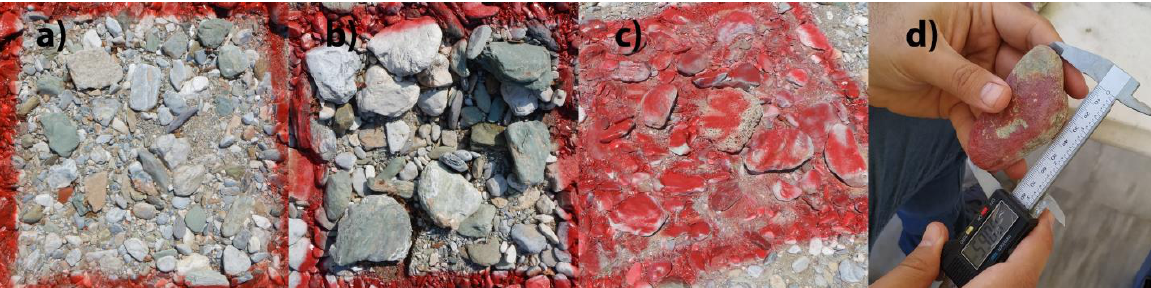
Figure 3. Grid sampling method of 1 m 2 [8] applied in grids of inhomogeneous bed composition ( a – c ) and axes measurements at laboratory facilities ( d ).